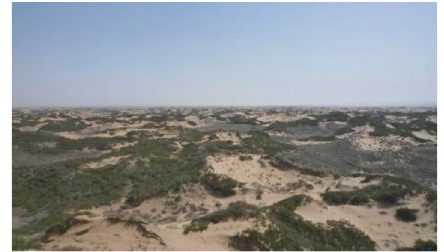
Figure 1: Aeolian sand landscape in Yuyang coal